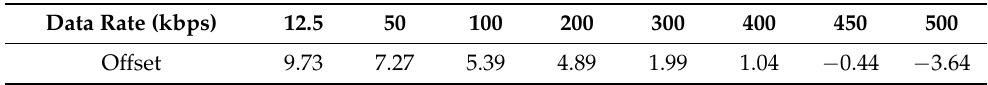
Table 3. Offsets of each data rate.